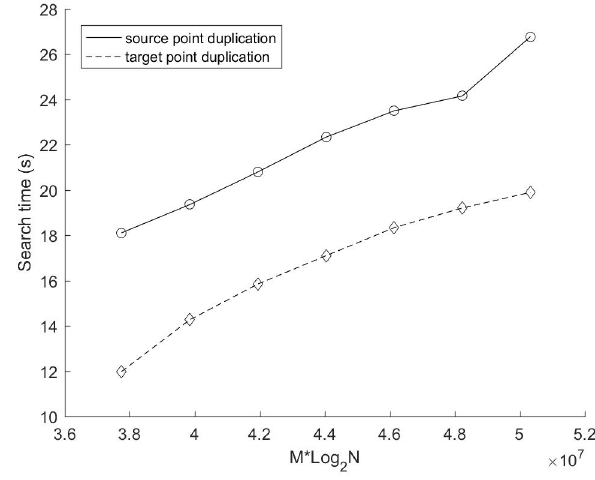
Figure 5. Search time with different number of source points.